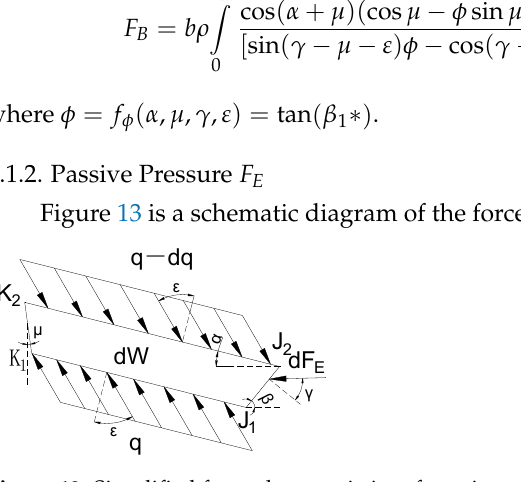
Figure 13. Simplified force characteristics of passive pressure.